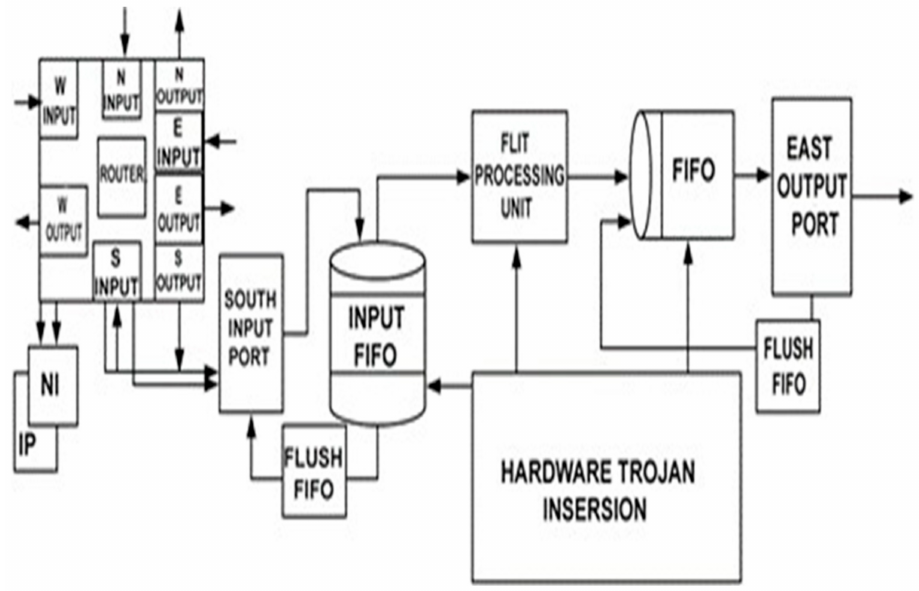
Figure 5. High-level view of the proposed